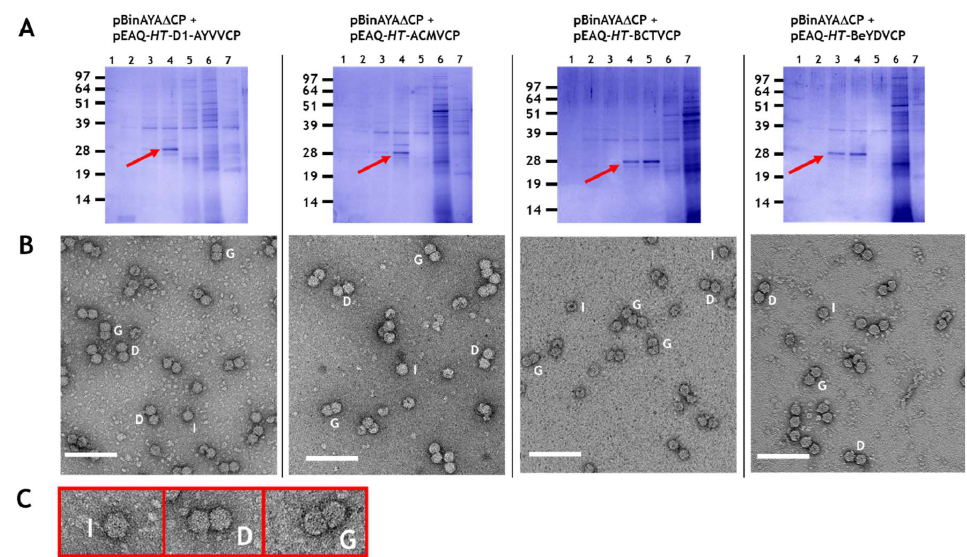
Figure 3. ( A ) An amount of 12% ( w/v ) MOPS-buffered NuPAGE gel resolution of caesium sulphate gradient separated virus particles. The infiltrated gene constructs for each are indicated above. Red arrows, caesium sulphate fractions that contain coat protein. ( B ) Transmission electron microscopy of caesium sulphate fractions that contain coat protein. I, isometric; D, double and G, geminate morphological virus particles. Bar = 100 nm. ( C ) Expanded images of I, D and G virus-like particles.